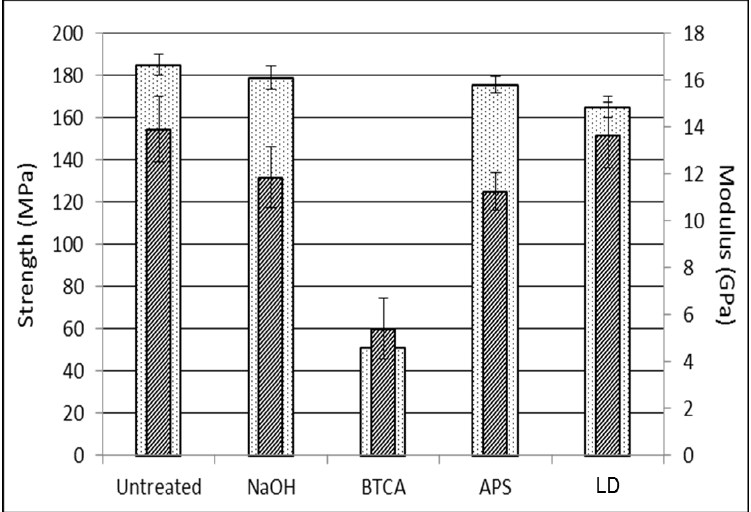
Figure 5. Tensile strength and modulus of hybrid FE